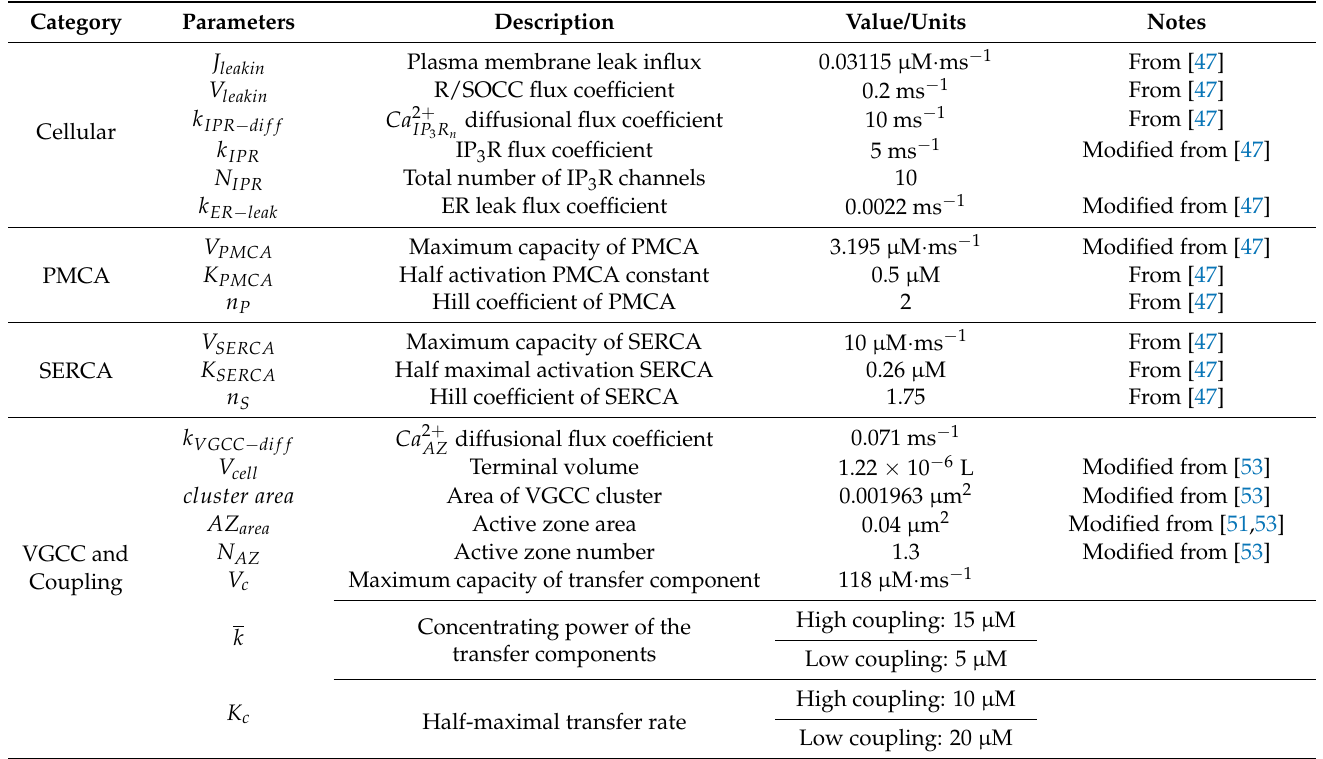
Table 2. Parameter values for the Ca 2+